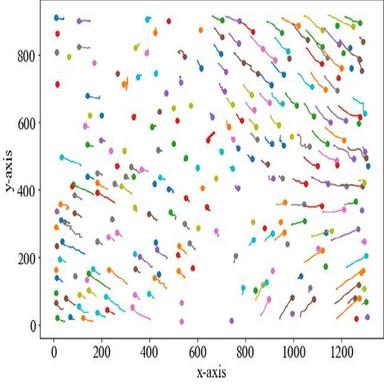
Graph of tracked cell trajectories up to 20% macroscopic strain. The centroid of the tracked cells is used to illustrate trajectories. The circular end represents the final location after 20% strain. (The color-coding has no specific meaning. It is to improve readability with a better visual appearance.).